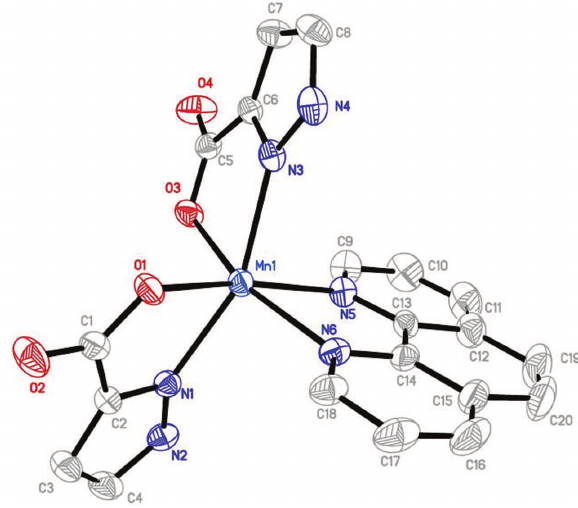
Table 1: Data collection and